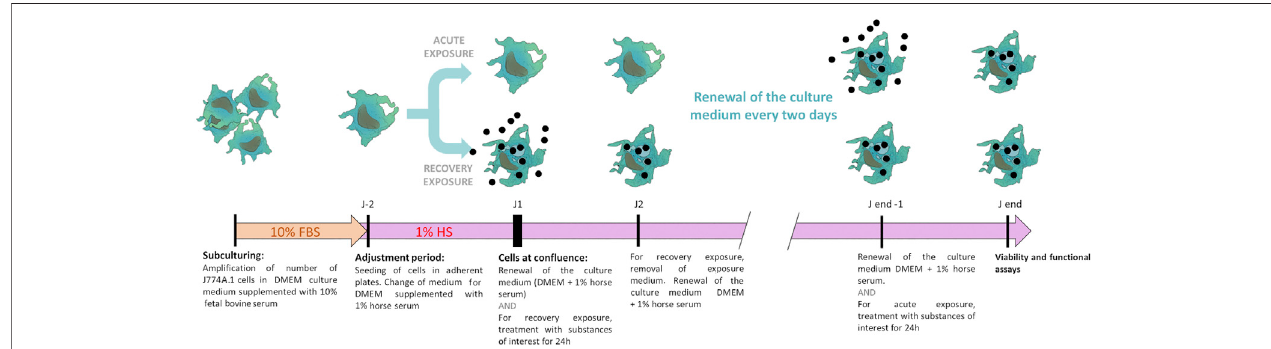
FIGURE1| Schematicrepresentationofthetwo-phaseculturesystem.Thecellsare fi rstampli fi edinenrichedculturemedium(containing10%fetalbovineserum), then transferred in the low-serum culture medium (containing 1% adult horse serum), to which they are fi rst adapted. The exposure and the recovery phases are then carried out, prior to fi nal biological endpoints